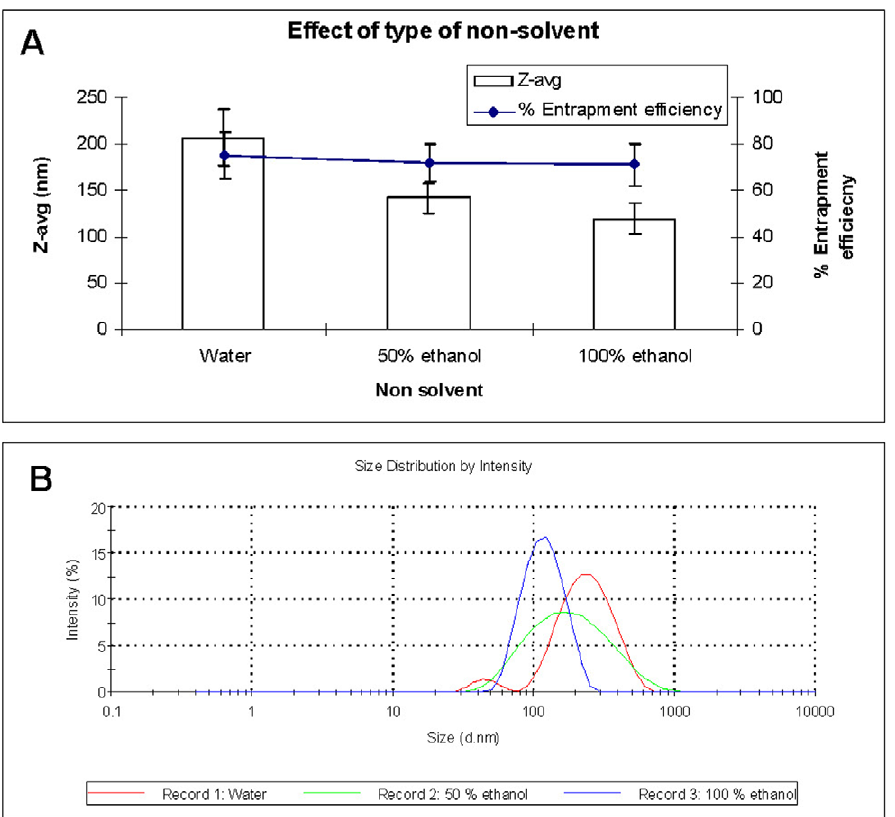
Figure 1. The effect of non-solvent composition on particle size, entrapment efficiency (A) and particle size distribution (B). PDI, water: 0.3 6 0.1; 50% ethanol 0.1 6 0.07; ethanol 0.1 6 0.02.